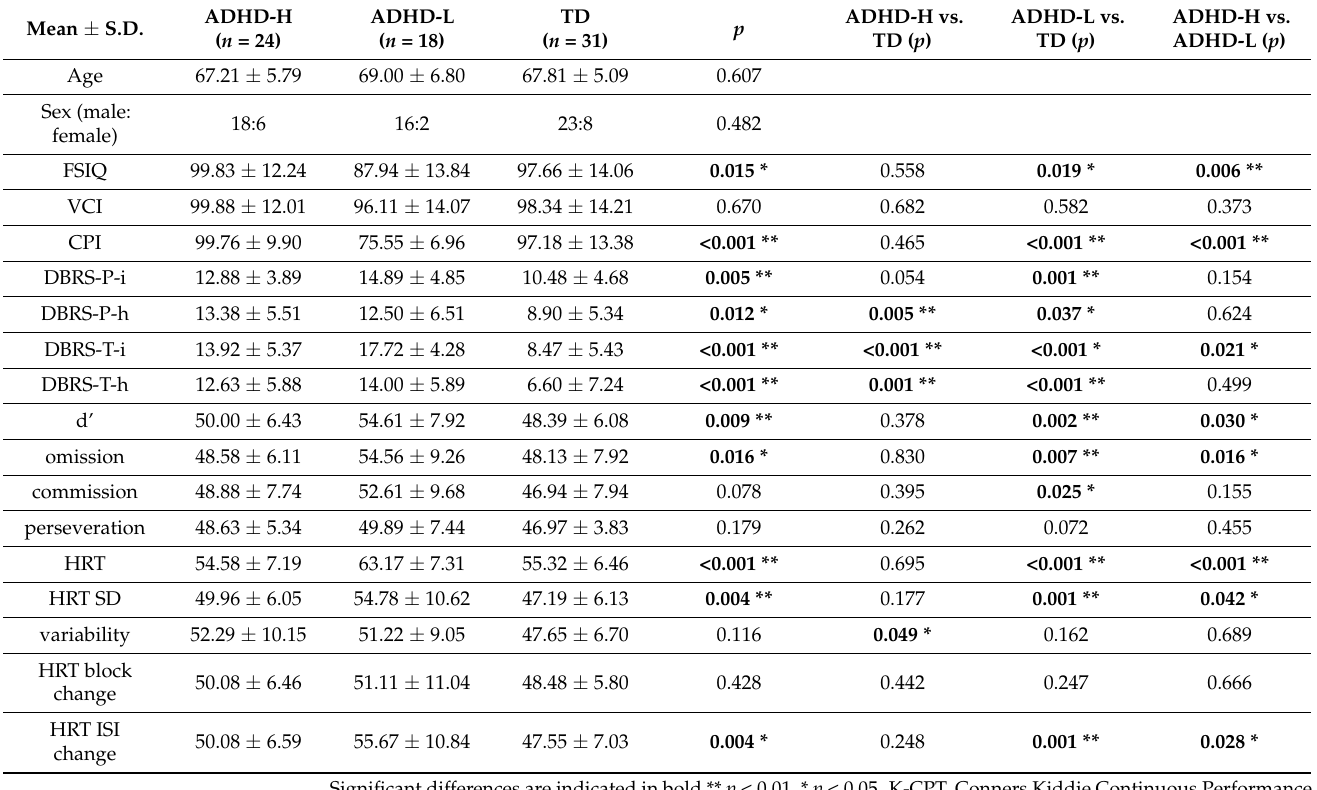
Table 1. Demographic characteristics and K-CPT values of the participants.